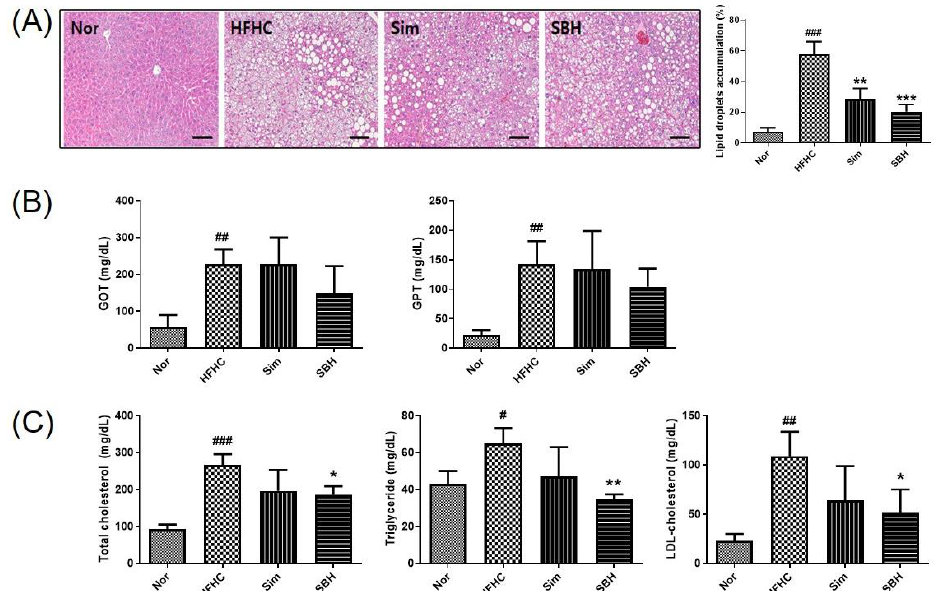
Figure 3. Effect of SBH on the histological change of liver tissue and the plasma levels of lipid parameters. Histological images of liver tissues from representative mice in each group ( A ). Tissues were fixed, embedded in paraffin, and stained with hematoxylin and eosin (H&E). Images are shown at the original magnification of ×200, and the scale bar is 1 mm. Quantification of lipid droplet area in the experimental animals. Data are expressed as a percentage of the area of lipid droplets in the field. The levels of plasma GOT and GPT ( B ) and the total cholesterol, triglyceride, and LDL-cholesterol were measured ( C ). The number of experiments: Nor ( n = 4), HFHC ( n = 4), Sim ( n = 4), SBH ( n = 4). Data are expressed as the mean ± SEM. # p < 0.05, ## p < 0.01, ### p < 0.001 compared with